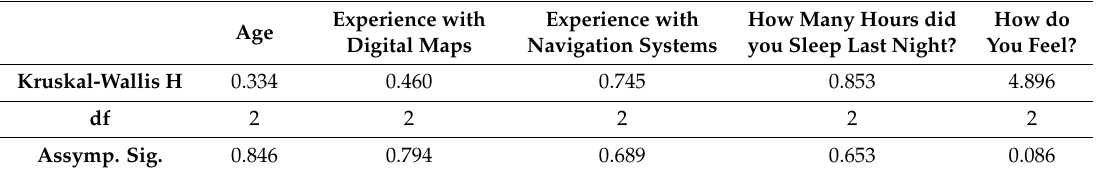
Table 4. Kruskal–Wallis H Test results regarding pre-study participants’ answers, for the three conditions. Experience with Experience with How Many Hours did How do Age Digital Maps Navigation Systems you Sleep Last Night? You Feel? Kruskal-Wallis H 0.334 0.460